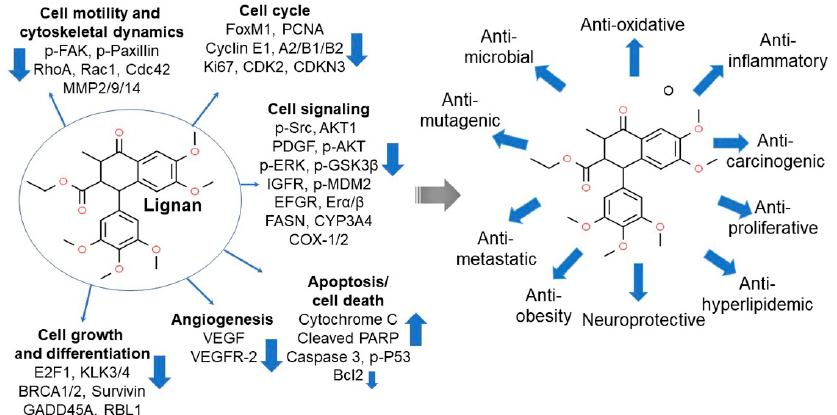
Figure 9. The cellular and molecular targets for anticancer ( left panel ) and protective health benefits of lignan ( right panel ). Cancer metastatic potentials are downregulated by blocking the cytoskeleton-driven cell mobility precursors. Regulation of cell differentiation and proliferation and cell cycle arrest can also interfere with survival and growth of cancer cells. Antiangiogenic starvation of tumor cells and apoptotic induction contribute to tumor progression, survival, and inva- sion potentials. Inhibiting various cellular signaling pathways associated with downstream intra- cellular kinases, including AKT, ERK, and mitogen kinases, regulates cellular metabolic pathways, triggering the suppressed tumor growth and progression [91]. In addition, lignan-containing diets or supplements can enhance general health and prevent various diseases. Cdc42, cell division con- trol protein 42 homolog; AKT1, RAC-alpha serine/threonine-protein kinase; p-FAK, phosphory- lated focal adhesion kinase; GADD45A, growth arrest and DNA damage inducible alpha; IGFR, insulin-like growth factor 1 receptor; p-ERK, phosphorylated extracellular-signal-regulated kinase; p-paxillin, phosphorylated focal adhesion-associated adaptor protein; RhoA, Ras homolog family member A; Rac1, Ras-related C3 botulinum toxin substrate 1; MMP2/9/14, matrix metalloprotein- ase-2, -9, and -14; FoxM1, forkhead box protein M1; PCNA, proliferating cell nuclear antigen; Cy- clin, a protein family that controls the progression of a cell through the cell cycle; MKI67, marker of proliferation Ki-67; CDK2, cyclin-dependent kinase-2; CDKN3, cyclin-dependent kinase inhibi- tor 3; p-Src, phosphorylated proto-oncogene tyrosine-protein kinase; PDGF, platelet-derived growth factor; p-AKT, phosphorylated protein kinase B; p-GSK3 β , phosphorylated glycogen syn- thase kinase 3 beta; p-MDM2, phosphorylated E3 ubiquitin-protein ligase; EGFR, epidermal growth factor receptor; ER α / β , estrogen receptor alpha/beta; FASN, fatty acid synthase; CYP3A4, cytochrome P450 3A4; COX-1/2, cyclooxygenase-1/2; E2F, E2 factor; E2F1, E2F transcription factor 1; KLK3/4, prostate-specific antigen 3/4; Survivin (BIRC5), an inhibitor of apoptosis protein; RBL1, retinoblastoma-like protein 1; VEGF, vascular endothelial growth factor; VEGFR2, vascular endo- thelial growth factor receptor-2; Cytochrome C, a heme protein localized in the compartment be- tween the inner and outer mitochondrial membranes; PARP, poly (ADP-ribose) polymerase; Caspase-3, an endo-protease which regulates inflammatory and apoptotic signaling networks; p- p53, phosphorylated tumor suppressor p53; Bcl-2, B-cell lymphoma-2 as an apoptotic regulator. Figure adapted from De Silva, S.F. et al. [91].